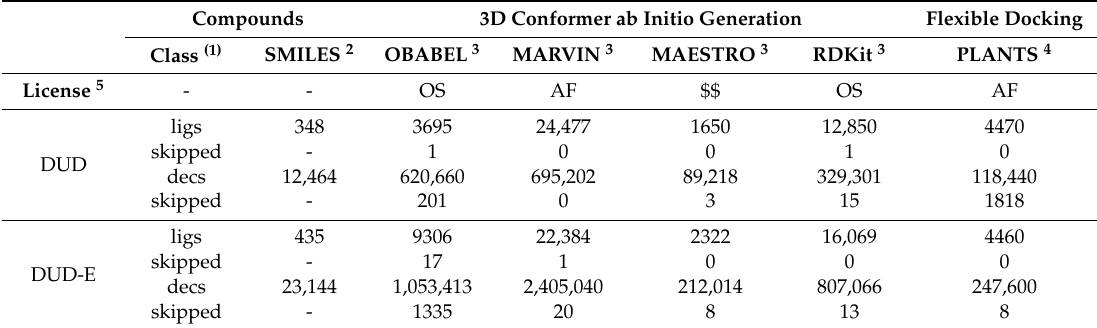
Table 1. Ligand 3D conformers for the cyclooxygenase-2